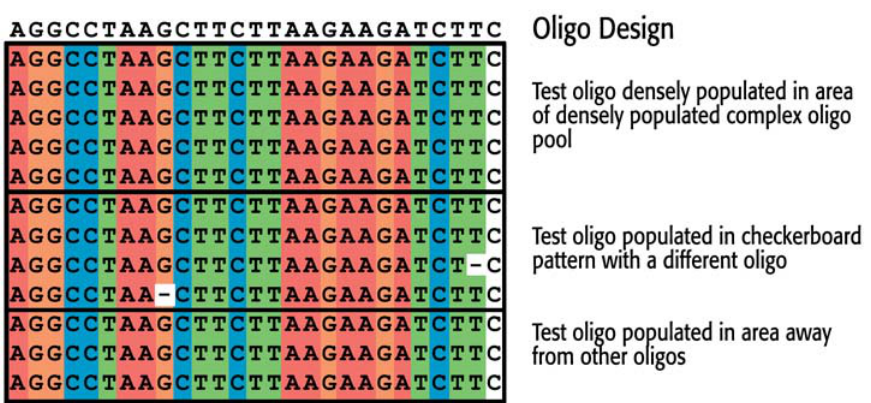
Figure 7. Results from the cloning and sequencing of DNA removed from the microarray.